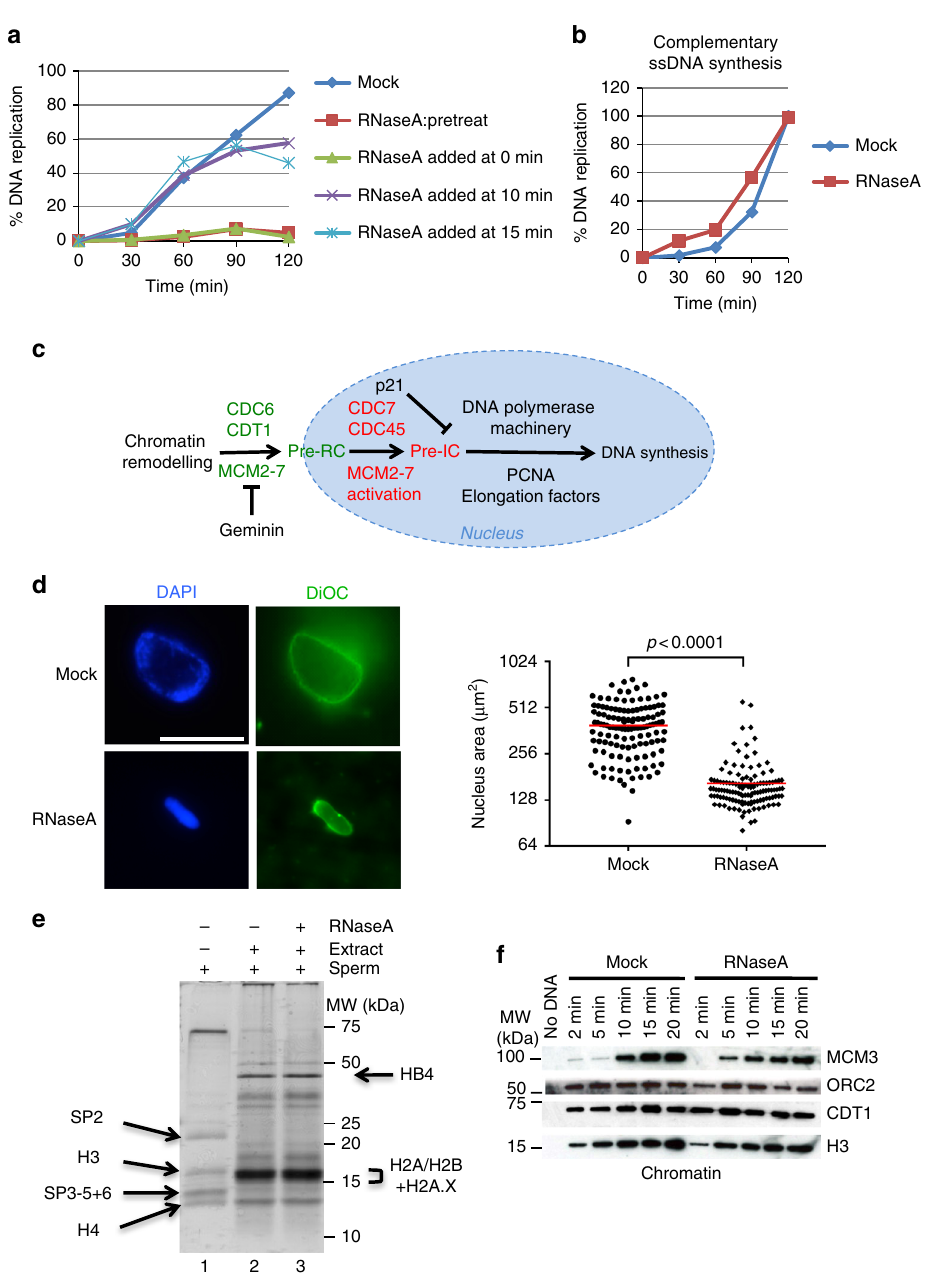
Fig. 1 Incubation with RNase A inhibits DNA replication but not pre-RC assembly. a Replication kinetics of LSEs incubated with RNase A before (pretreat), at the same time (0 min), and 10 or 15 min after addition of sperm nuclei. b M13 ssDNA replication is not affected by LSE pre-incubation with RNase A, c Scheme illustrating the steps leading to the assembly of the complexes involved in the licensing reaction (green) and in DNA replication activation (red). The blue circle highlights reactions occurring in the nucleus. d Sperm nuclei incubated in mock or RNase A-treated LSE for 60 min were fi xed in the presence of DiOC 6 (green) and DAPI (blue). Scale bar, 17 μ m. The nuclear size of 125 nuclei per condition was measured based on the DAPI staining area (right panel). Red bar, mean value. A two-tailed Student ’ s t -test was performed to determine the p -values. e Histones from sperm nuclei were isolated by acid extraction before and 5 min after incubation in mock or RNase A-treated extracts. DNA-bound proteins were then analysed by gel electrophoresis and silver staining. f Time-course analysis of pre-RC assembly in HSE (chromatin puri fi cation followed by western blotting with speci fi c